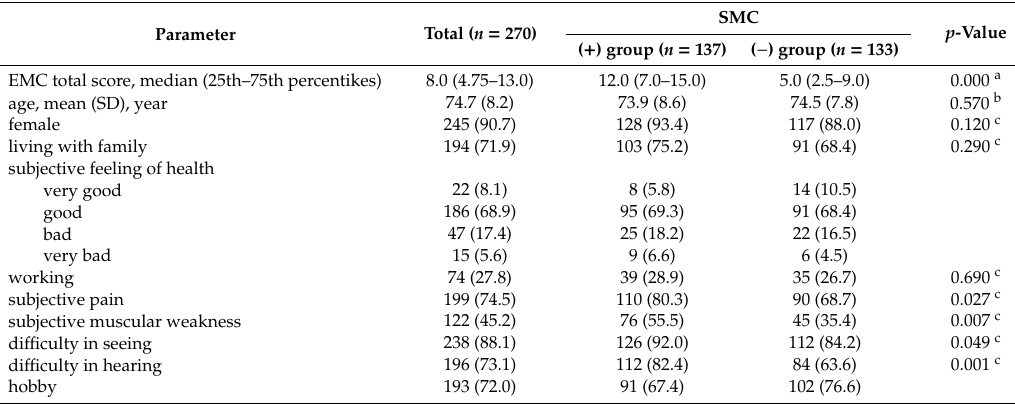
Table 3. Characteristics of